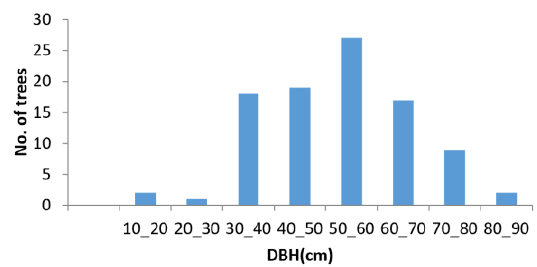
Figure 8. Number of trees under different DBH classes